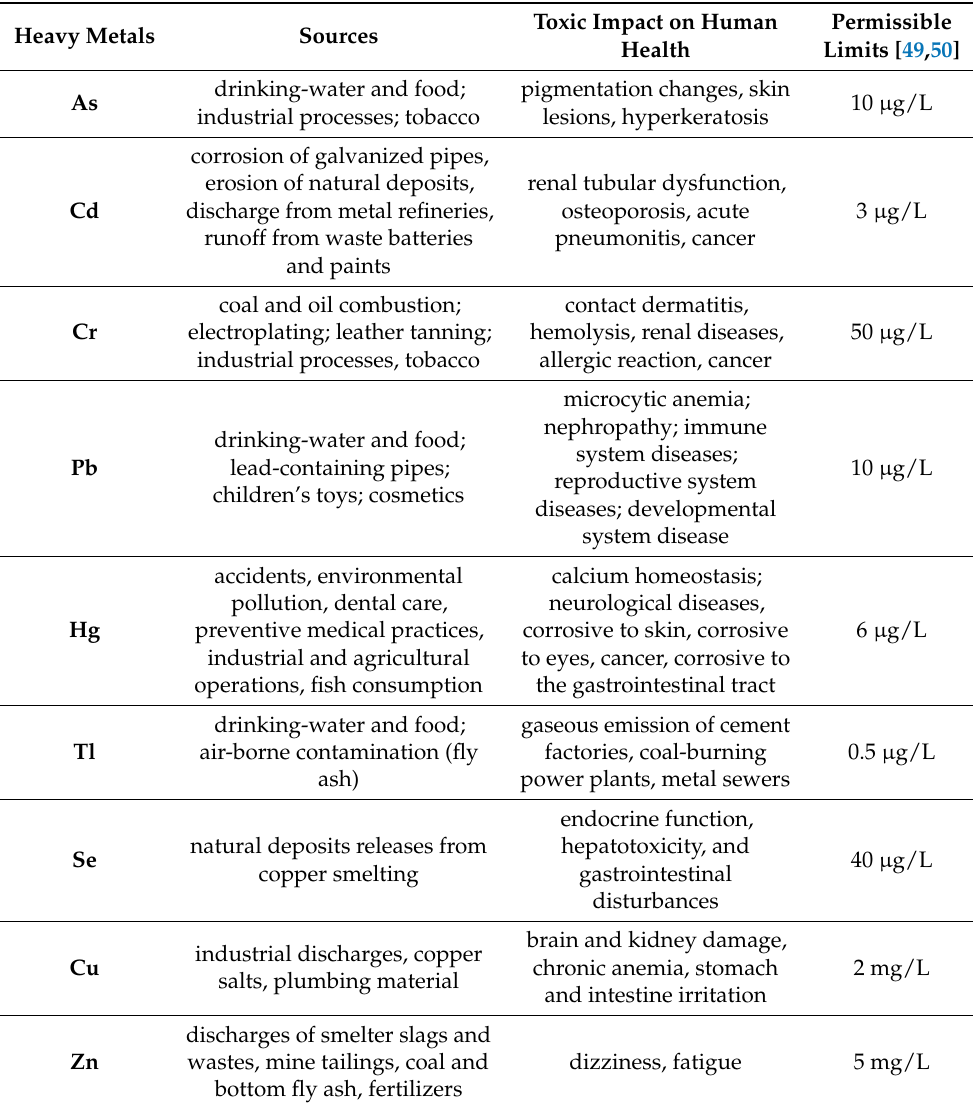
Table 2. Sources of heavy metals and toxicity on human